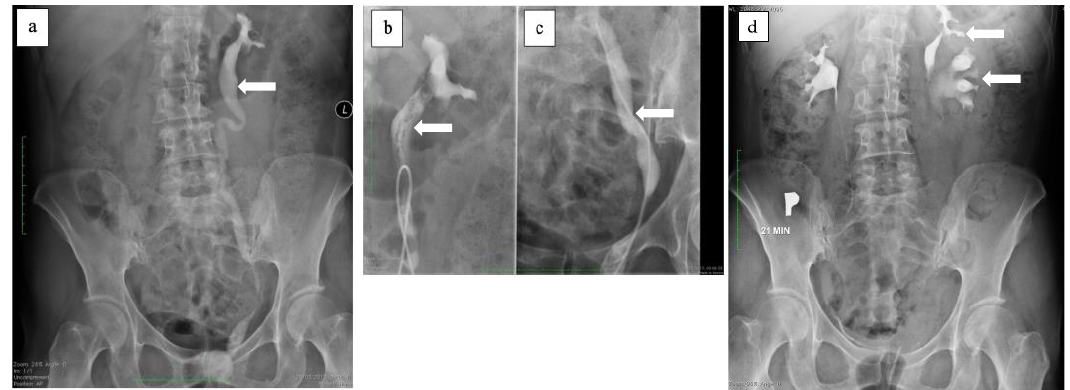
Figure 4. ( a ) Contrasted ectopic ureter (white arrow). ( b ) Contrasted proximal ectopic ureter (white arrow). ( c ) Contrasted distal ectopic ureter (white arrow). ( d ) Contrasted duplex kidney on the left side (white arrows) and normal pelvicalyceal system on the right side.